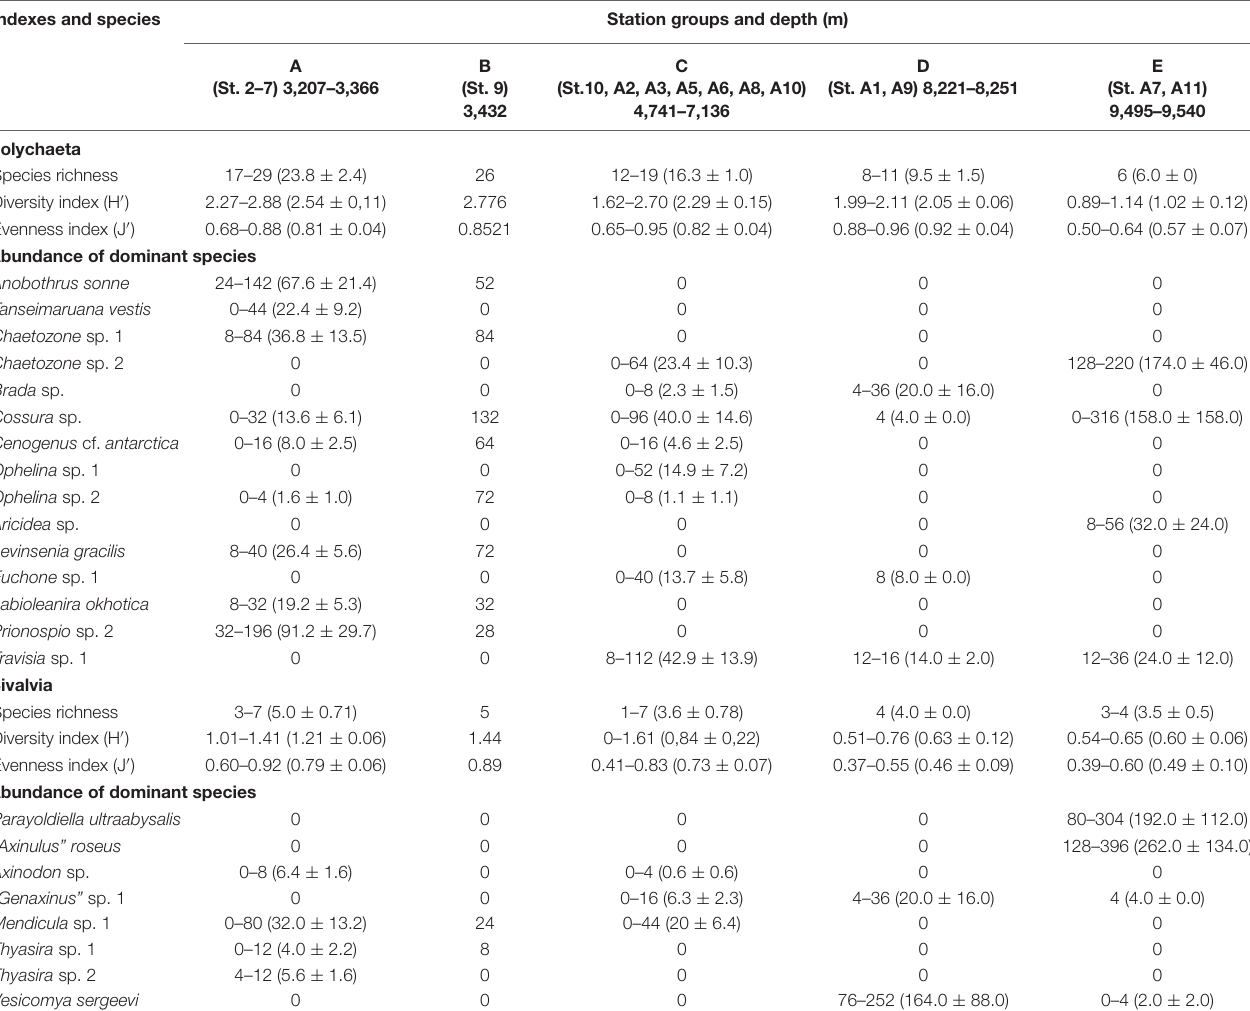
TABLE 5 | Species richness (number of species per sample), diversity indexes, and abundance (min—max, mean ± SE, ind. m − 2 ) of dominant species of polychaete and bivalve assemblages in five station groups (A–E), identified using Cluster and MDS analyzes of quantitative data ( Figure 3